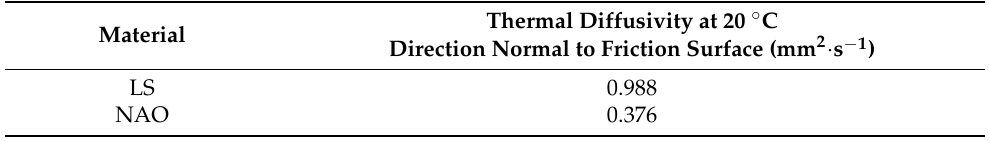
Table 2. Diffusivity values of the pad materials along the direction normal to their surfaces.